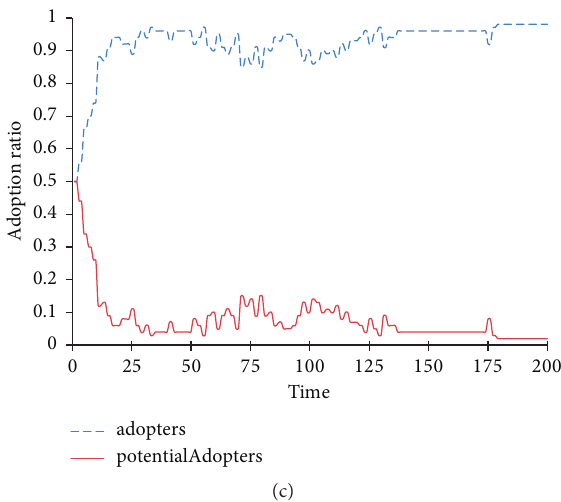
Figure 16: Effect of p on product diffusion. (a) p � 0.01, (b) p � 0.55, and (c) p �